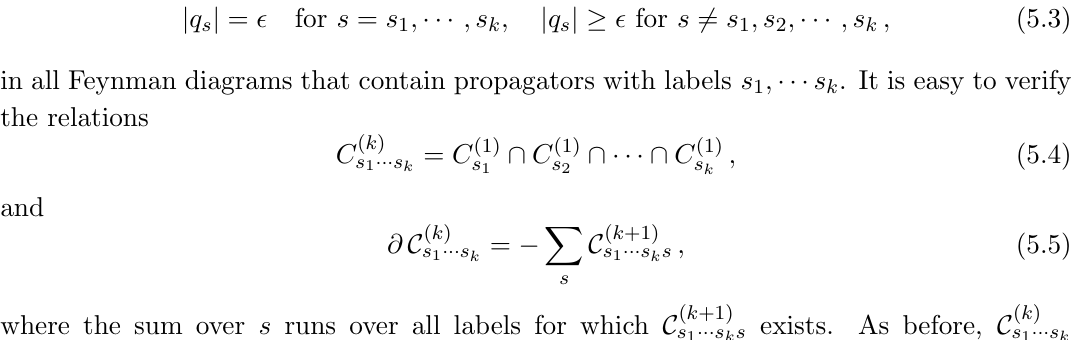
g this corresponds to restricting j q s